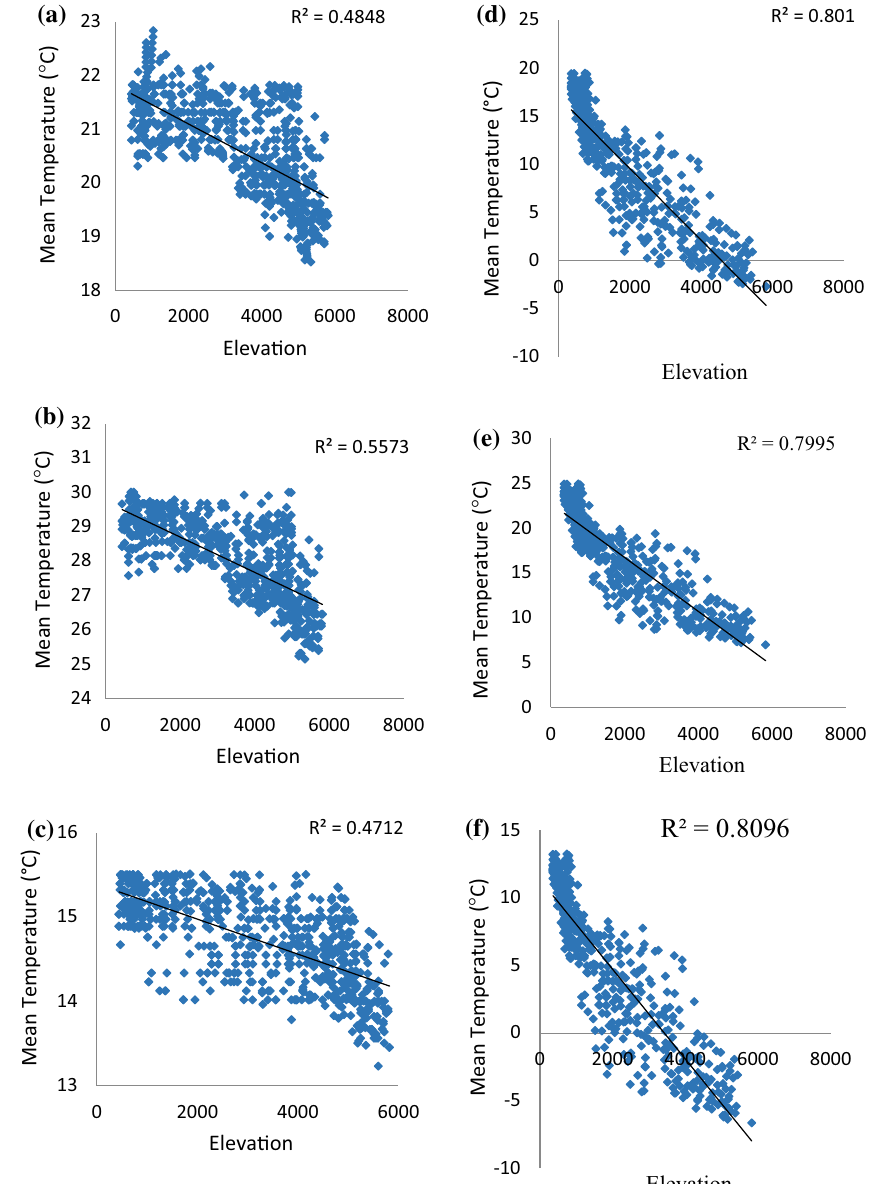
Fig. 7 Variation of mean temperature with elevation for monsoon, pre-monsoon and post-monsoon period for IMD ( a – c ) and ERA-Interim ( d – f )